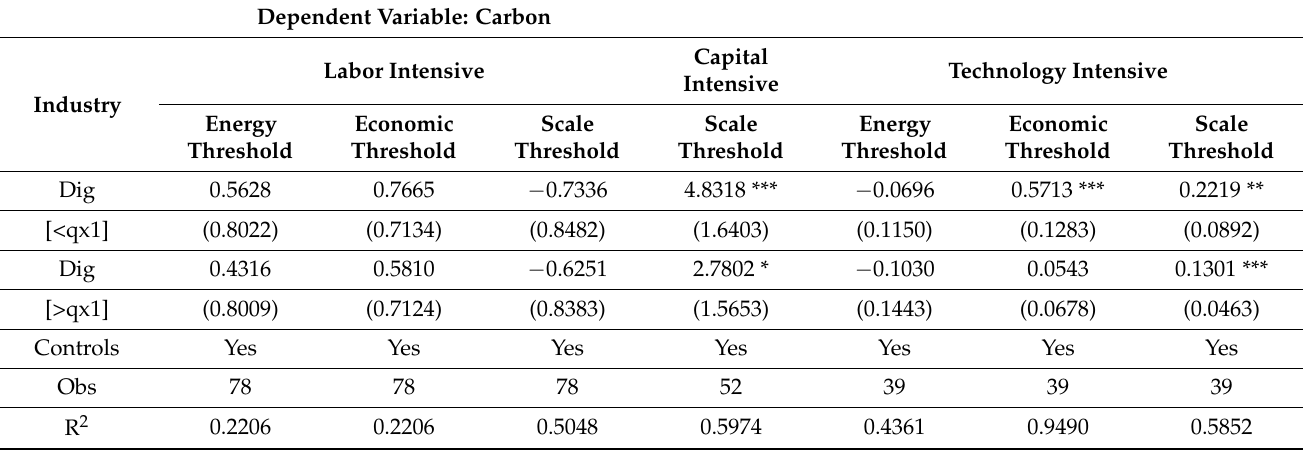
Table 8. Estimation results of the threshold